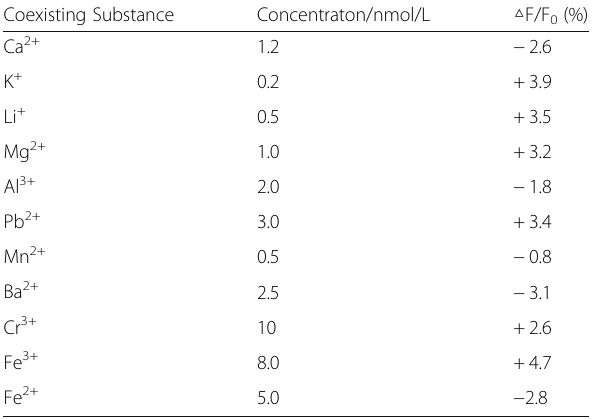
Table 1 Effect of interfering species on the fluorescence intensity of FRET sensor solution under optimum conditions